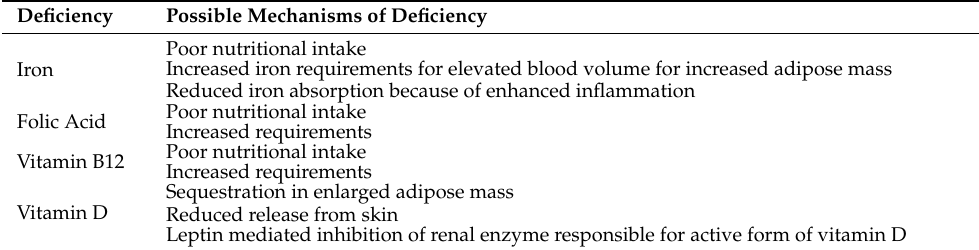
Table 3. Possible mechanisms of deficiency.